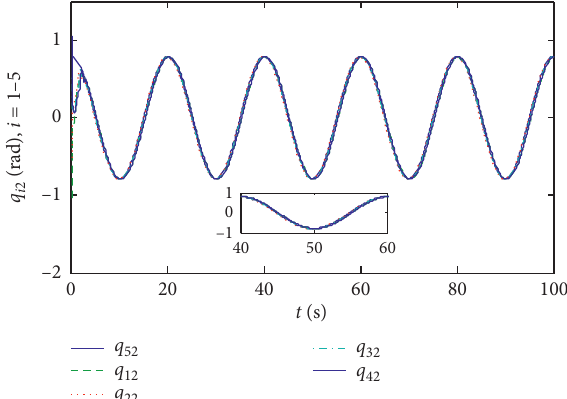
Figure 4: The generalized coordinates q